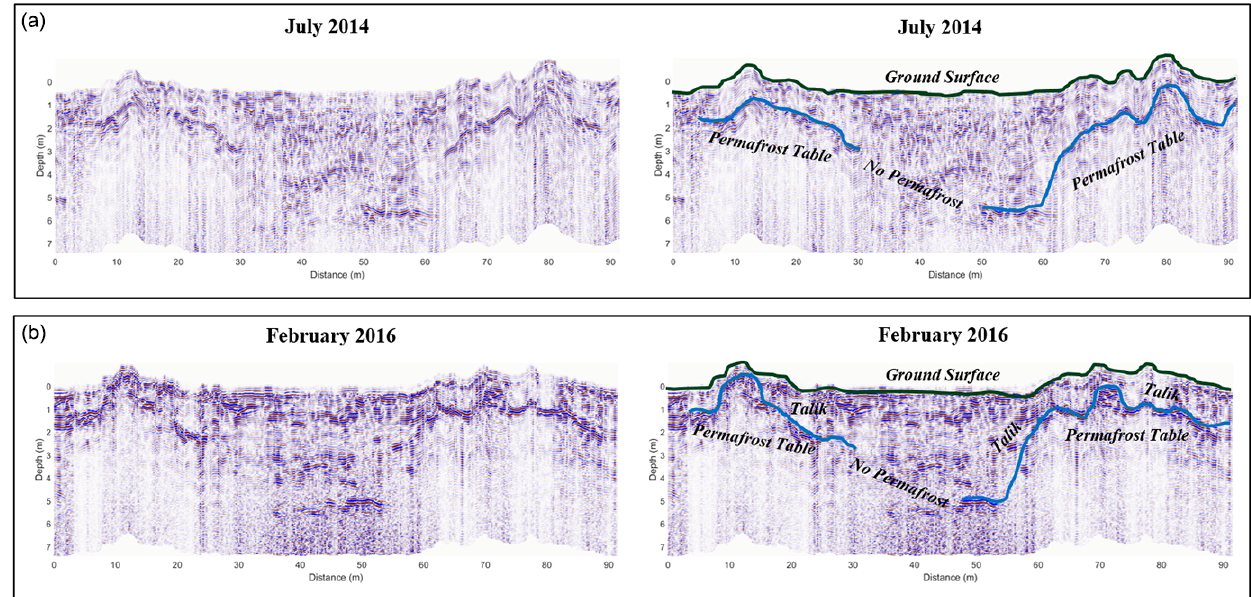
Figure 10. GPR profiles at the intensive Browns Lake permafrost plateau (Fig. 7a) from (a) late July 2014 with MALÅ shielded 100MHz antennas and (b) mid-February 2016 with Sensors&Software unshielded bistatic 100MHz antennas. Processed radargrams are on the left and processed, interpreted radargrams are on the right. Both summer and winter profiles clearly show reflectors associated with the permafrost table and in the case of (b) show the presence of a talik. However, we were unable to image the permafrost base using GPR. Note that the two GPR transects differ slightly in their orientation across the